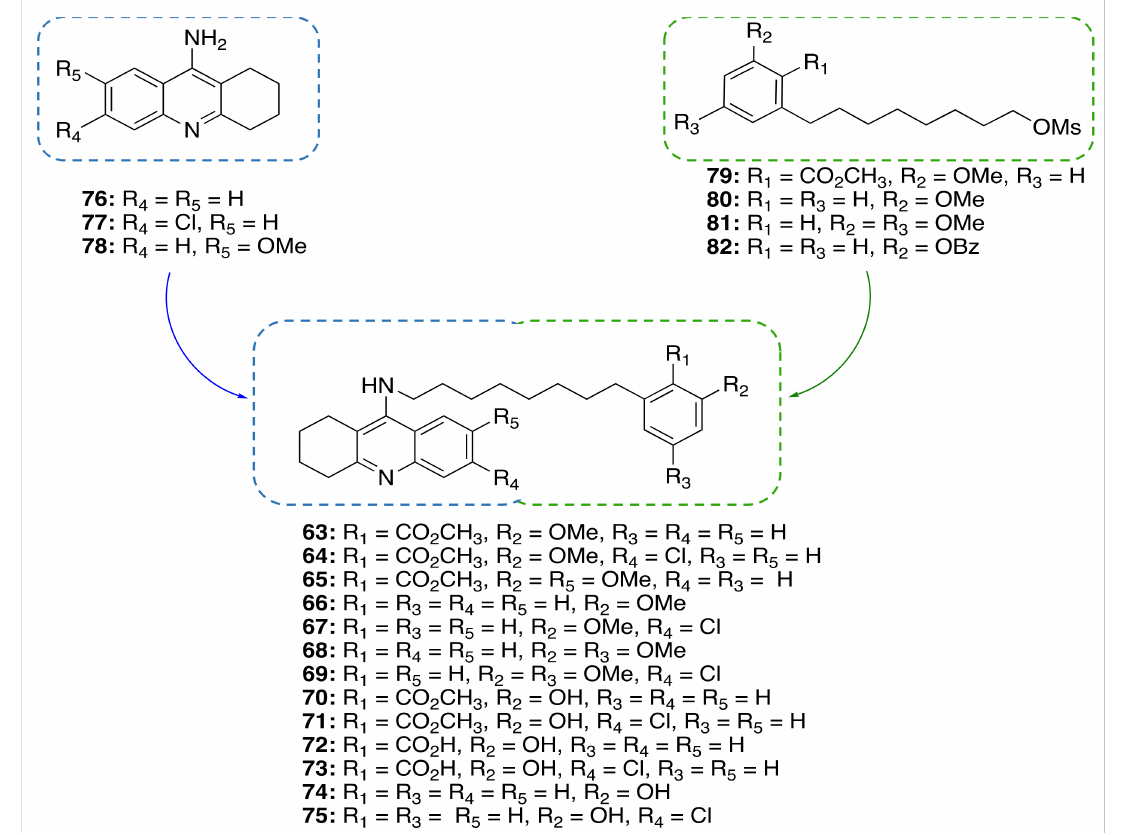
Figure 10. Design of CNSL-derived tacrine hybrid compounds 63–75